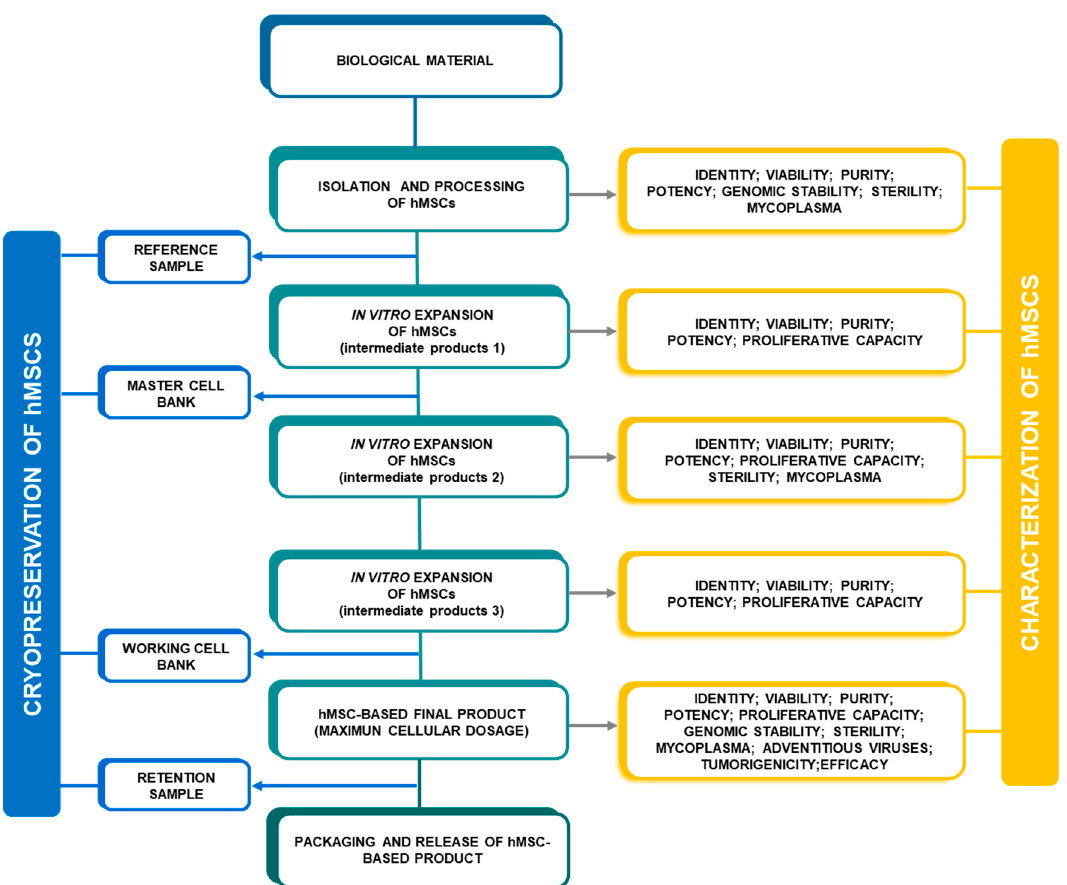
Figure 2. Example of an outline of the quality control program for the development of clinical-grade mesenchymal stem cells during the validation phase.